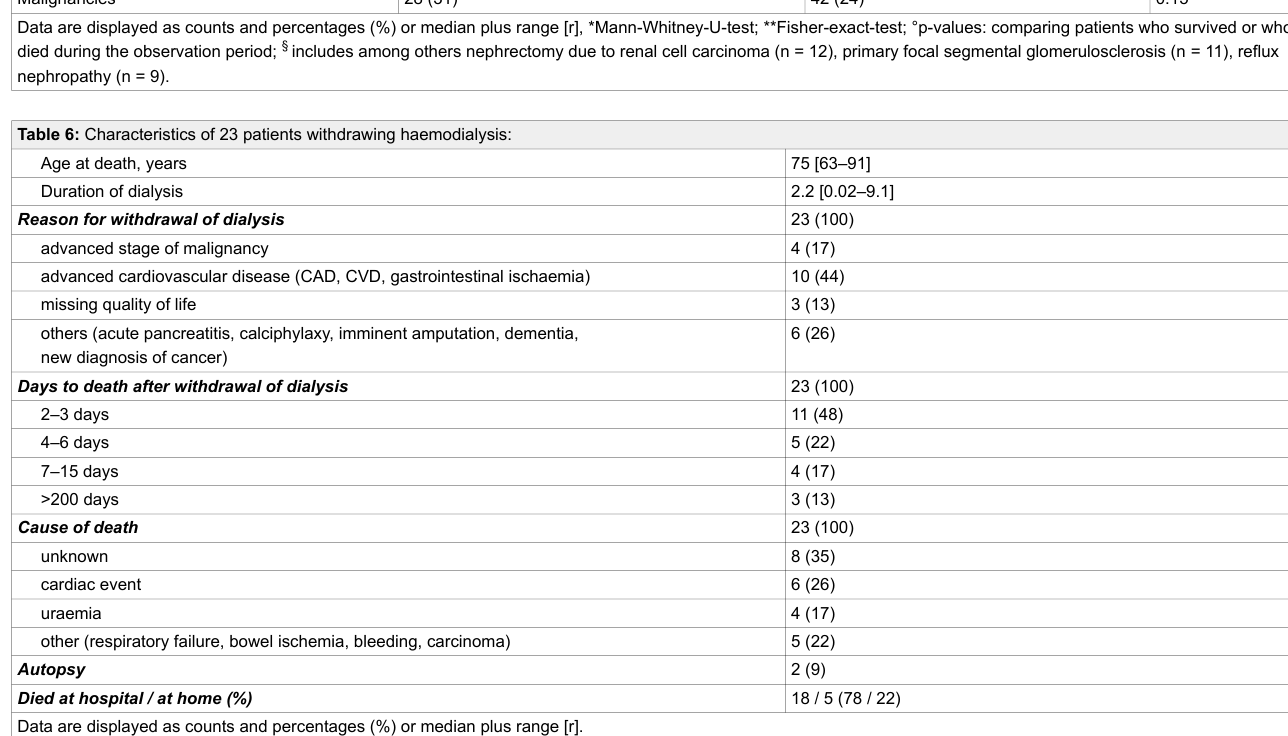
Coronary artery disease